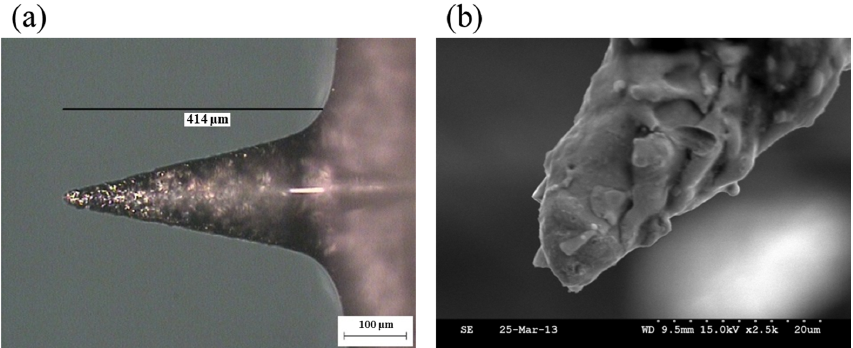
Figure17. Micro punch head morphology after stamping ( a ) OM image ( b ) partially enlarged SEM image. According to the experimental results, the Al6061 and C2680 workpieces are only punched 18 times with stamping depths of 300–380 μ m. Figure 17a is an OM picture of a punch head after stamping and it shows that the punch head is not broken. Figure 17b is a magnified SEM picture of a punch head tip. It shows the punch head is not broken or worn, as the WC has higher strength and